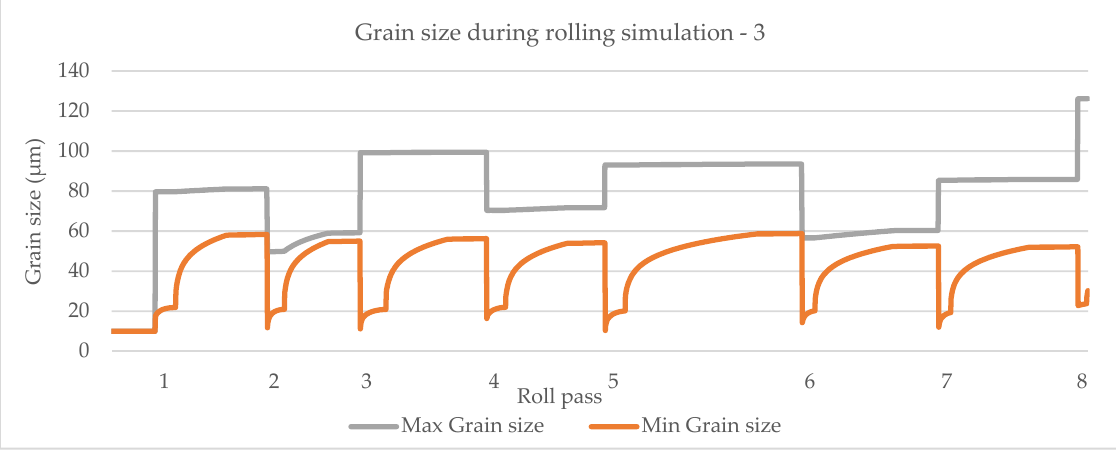
Figure 16. Simulation of maximum and minimum grain size based on the model by Manohar et al. [15].